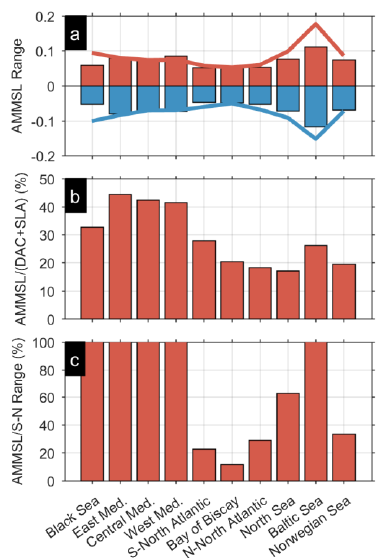
Figure 5. ( a ) Oceanographic region average of range of AMMSL (red / blue lines show the spatially averaged standard deviation of the interannual MMSL positive/negative values, respectively). ( b ) Oceanographic region average of the relative value (%) of AMMSL with respect to the SSL monthly maxima (SLA DAC ). ( c ) Oceanographic region average of the relevance (%) of mean AMMSL with respect to the neap-spring tidal range following Equation (3). (Exceedance of 100% were represented as 100% in order to facilitate the intercomparison with other regions). Remote Sens. 2020 , 12 , x FOR PEER REVIEW